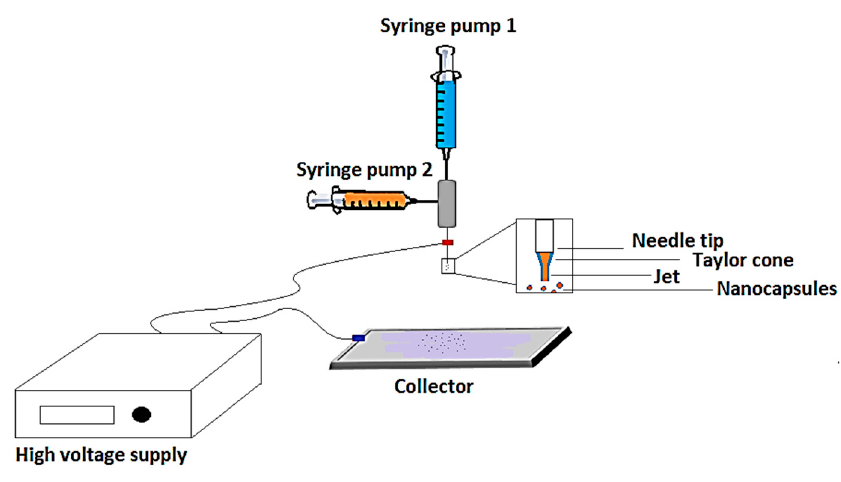
Figure 2. Schematic illustration of the employed coaxial electrospraying setup.